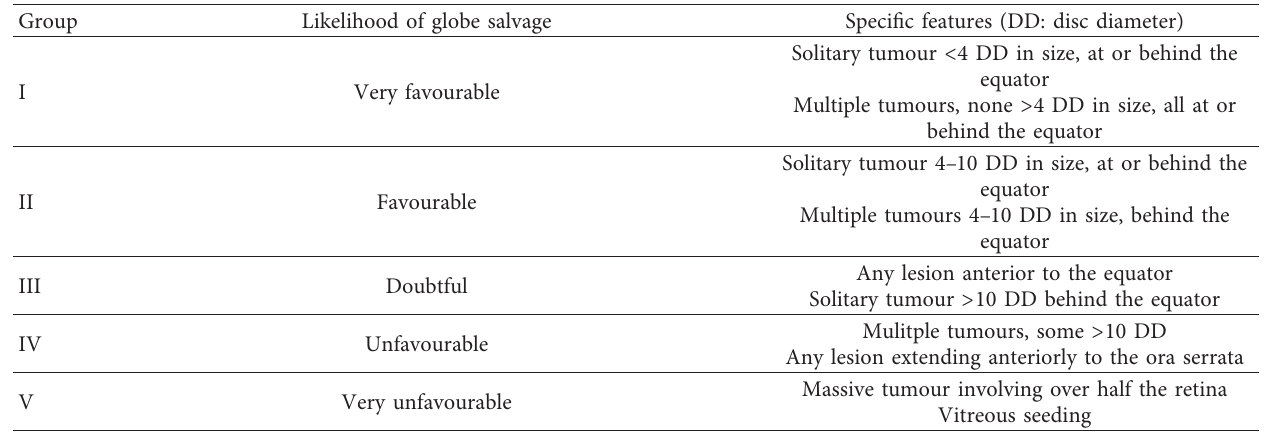
Figure 1: Retinoblastoma tumour grouping according to the International Intraocular Retinoblastoma 152 Classification. Group A: Tumour confined to the retina, > 3 mm away from the macula (a); Group B: 153 tumour confined to the retina, at the macular region (b); Group C: local seeding (arrow) (c); Group D: 154 diffuse vitreous seeding (d); and Group E: iris neovascularization of the iris and a large tumour seen 155 behind the crystalline lens (e) reproduced from Ido Didi Fabian and Mandeep S. Sagoo 2019, [under the 156 Creative Commons Attribution 4.0 International License] [13]. Table 2: Reese–Ellsworth classification for retinoblastoma